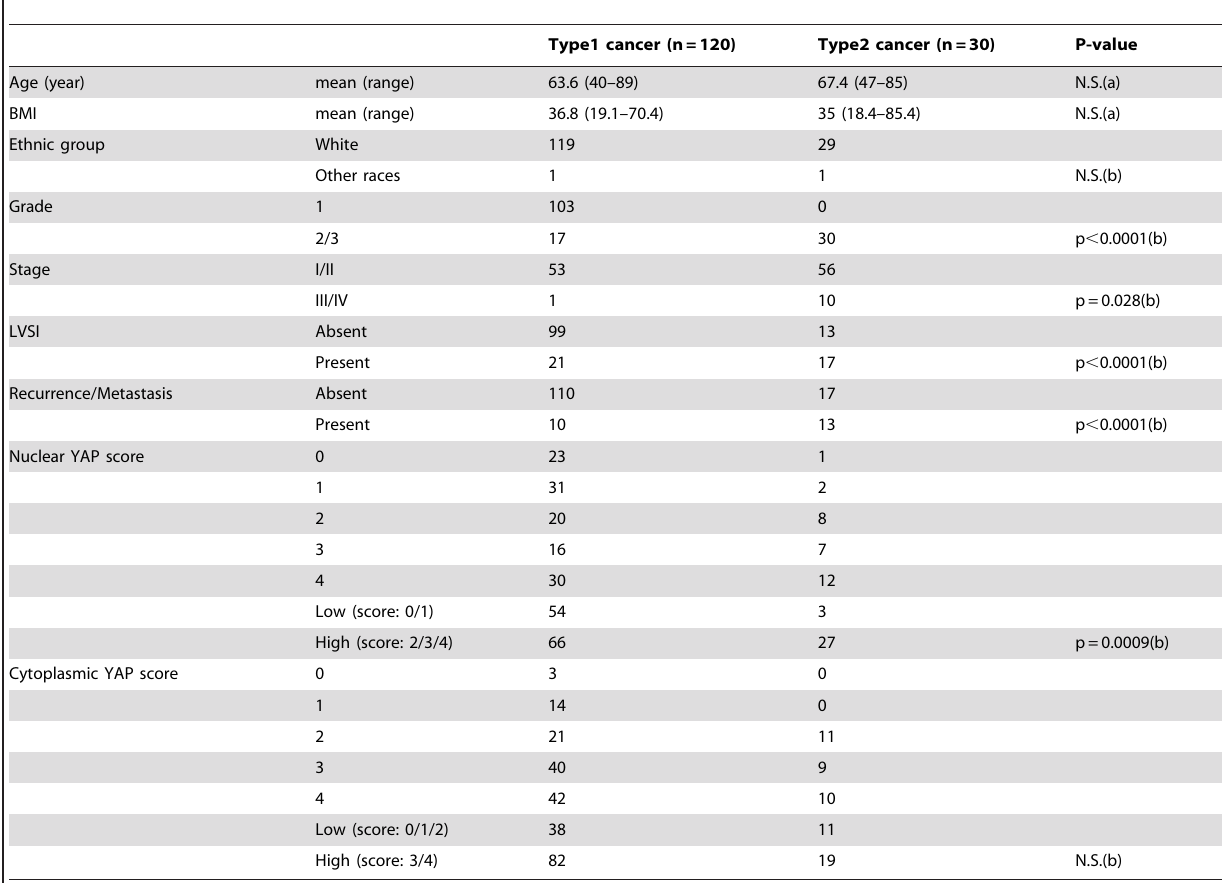
Table 1. Comparison of demographic data and YAP expression between type 1 and type 2 EMCA.